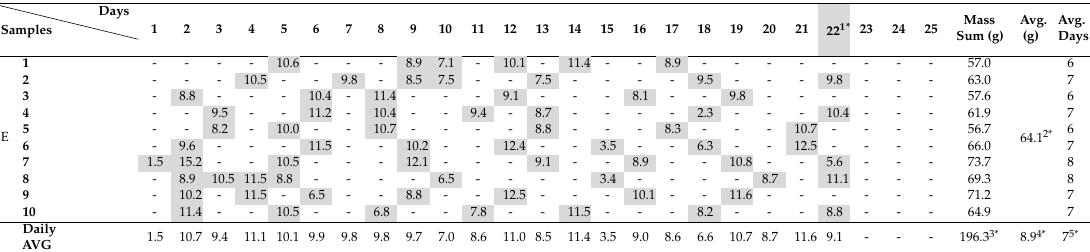
Table 9. Oil leakage mass measurement result (specimen